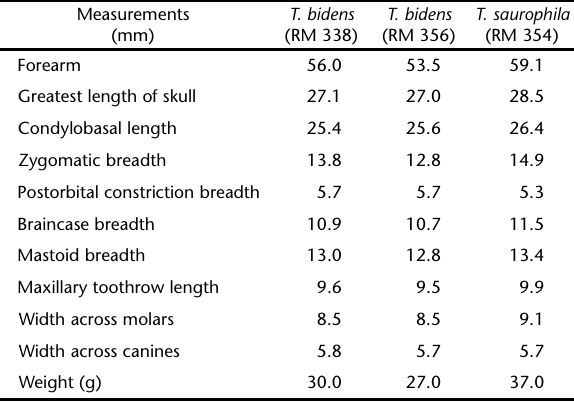
Table 1. External and cranial measurements (mm) of specimens of Tonatia bidens and T. saurophila captured in the Cerrado savanna of central